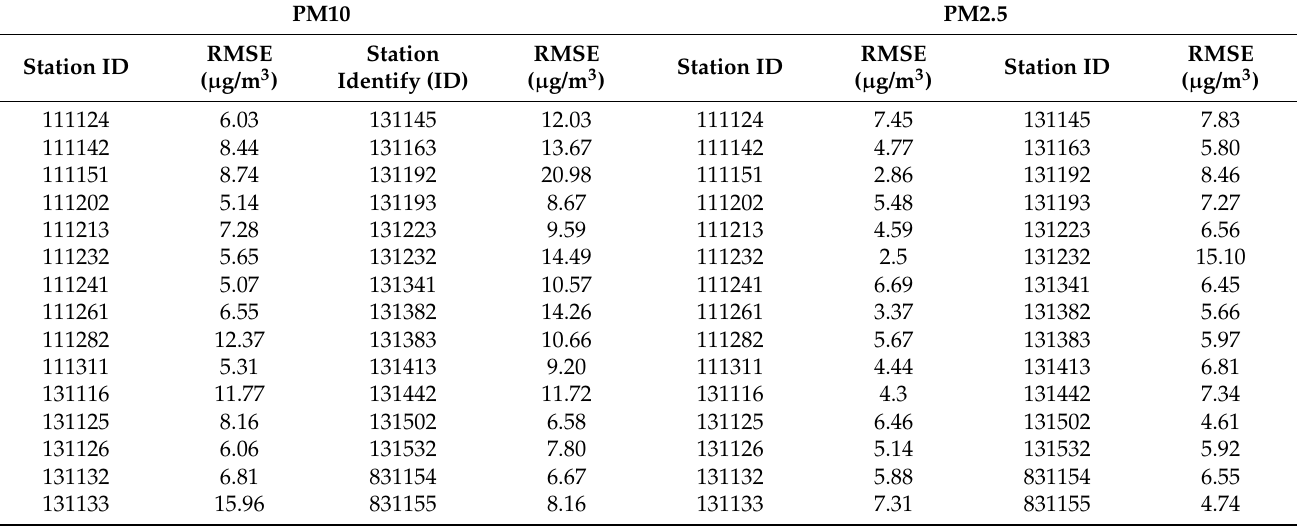
Table 3. RMSE values for different stations for PM estimation with modified IDW.